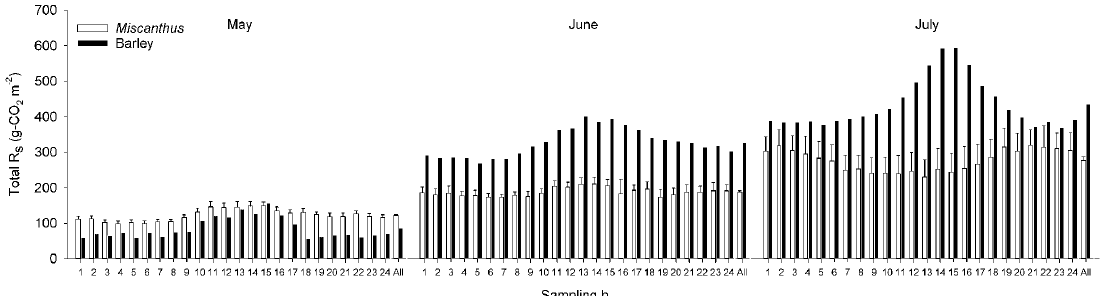
Figure 3. Estimates of the cumulative flux R s under Miscanthus and barley crops using measurements taken using only single hours (1–24) or continuous measurements (All) across 3 months in summer 2013. Values shown are mean cumulative flux ( ± 1SE, n = 6).